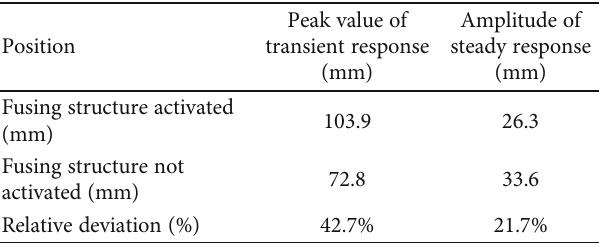
Table 8: Response value of a dual-rotor system with fractured fusing